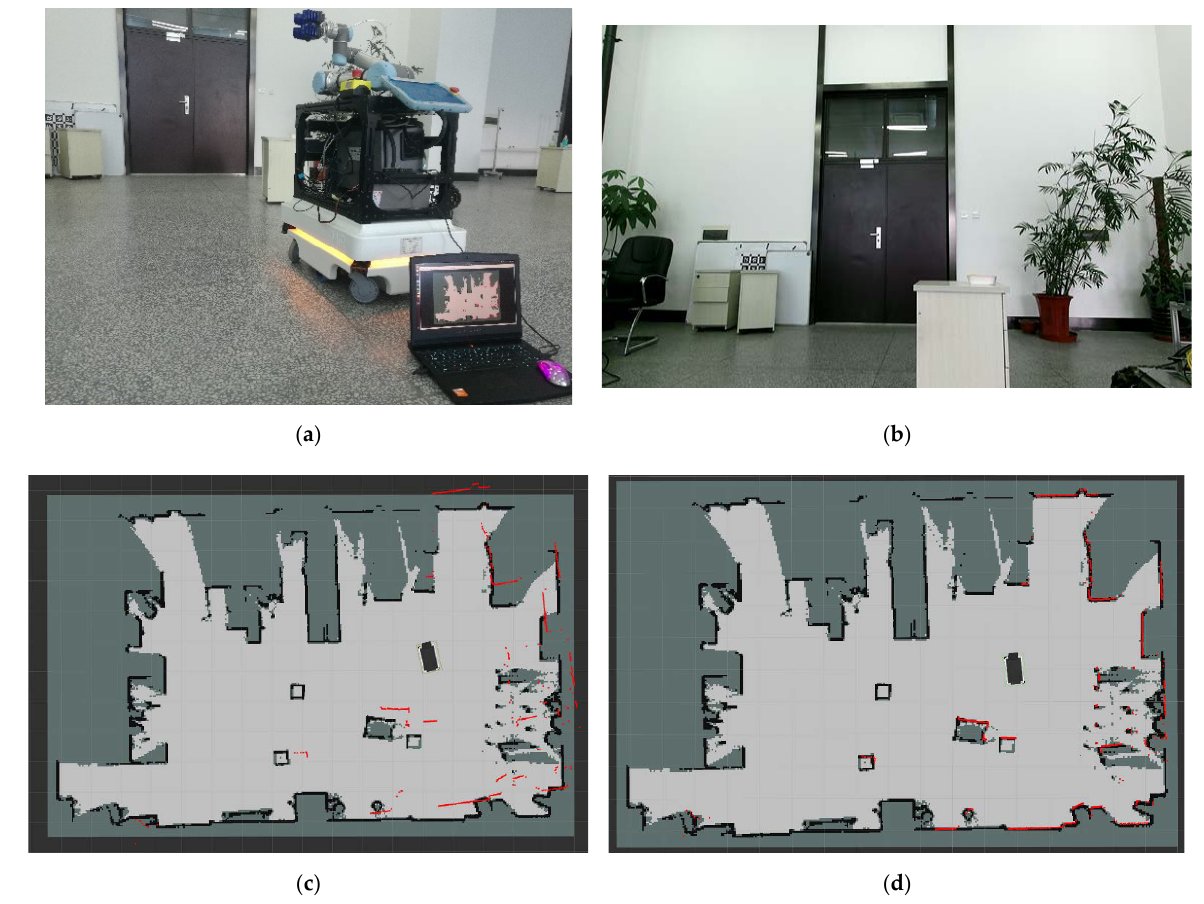
Figure 17. ( a ) Robot at test position; ( b ) Image acquired by camera; ( c ) The coarse relocation result based on vision; ( d ) The accurate relocation result fused with laser information.